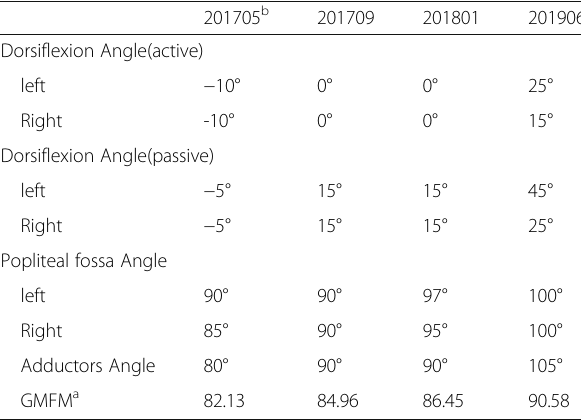
Table 1 Examination of rehabilitation